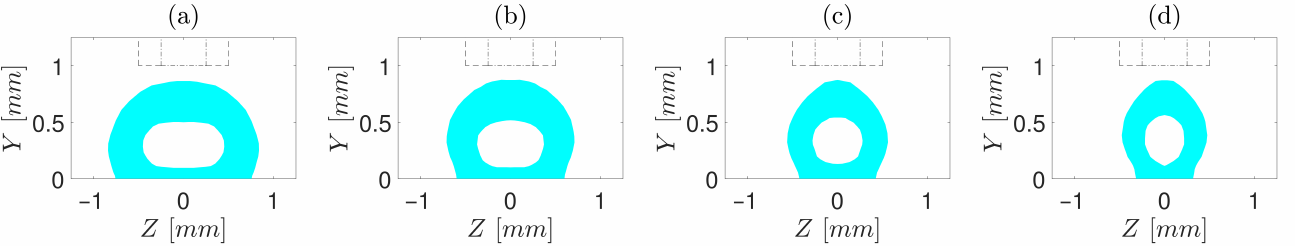
Figure 6. Cross-sections of core–shell strand for t / D = 1, d / D = 0.5 and different V / U of ( a ) 0.5, ( b ) 0.75, ( c ) 1, and ( d ) 1.25. Core diameter and orifice are marked by “- -” and “-·”,